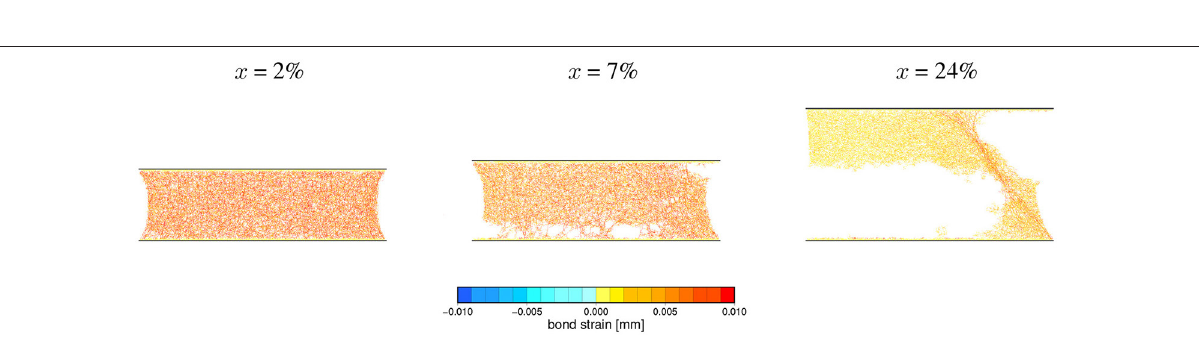
FIGURE 7 | An example of the ductile-like breaking mechanism. (Left) Force ( F )—thick black curve, Elastic energy (E e )—thin blue solid curve and the energy absorption rate ( E )—dashed red curve as functions of strain x . (Right) number of broken bonds in a fixed strain interval against x . A relatively fast increase of elastic energy at an initial phase is followed by a long-lasting stage of slowly changing elastic energy (left). At this stage, a slow destruction of the sample is observed (right) and the loading force needed to keep stretching speed constant exhibits significant fluctuations. The particle-particle interaction parameters for this case read: k n = 10 7 N/mm, b d = 0.01 mm.